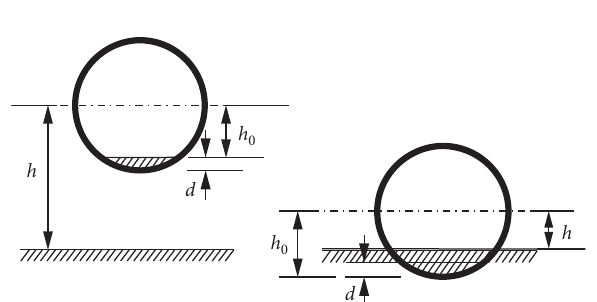
Figure 4: Impact contact